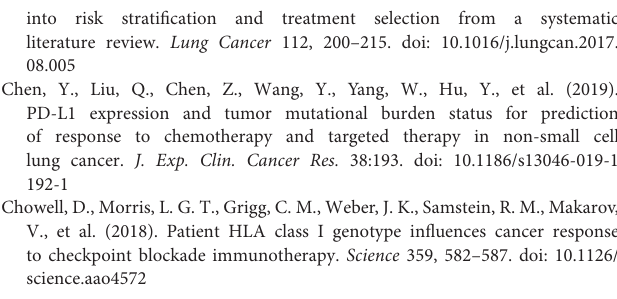
Supplementary Figure 1 | KM survival curves for PFS in NSCLC patients (ICI-treated cohort) grouped according to TMB levels and mutation status of lipids metabolism. Supplementary Figure 2 | KM survival curves for PFS in NSCLC patients (ICI-treated cohort) grouped according to TMB levels. Supplementary Figure 3 | The mutual exclusivity analysis of lipid metabolism genes in the high and low mutation groups. Supplementary Figure 4 | Comparison of mutation frequencies of lipid metabolism genes between the high and low mutation groups in the ICI-treated cohort (Rizvi et al.,